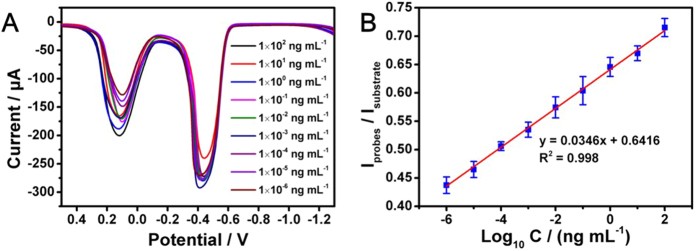
(A) SWV responses of the immunosensor for different concentrations of IgG. (B) Calibration curves between the Isubstrate/Iprobe and logarithm of IgG concentration.